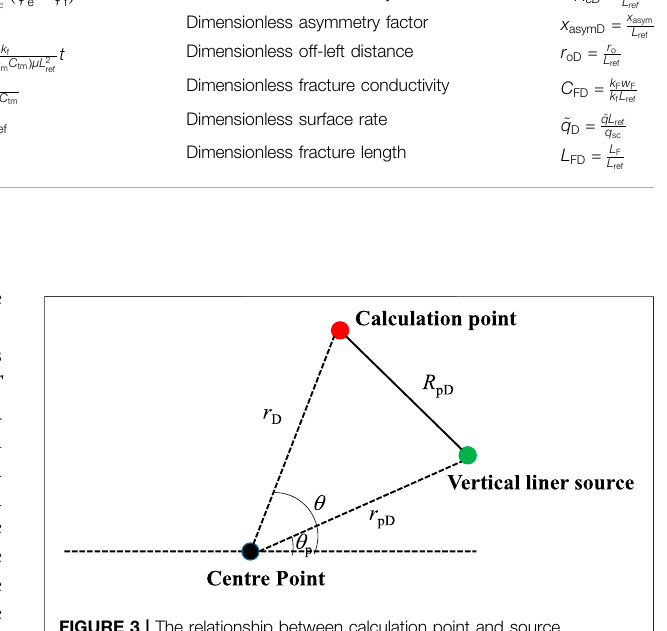
FIGURE 3 | The relationship between calculation point and